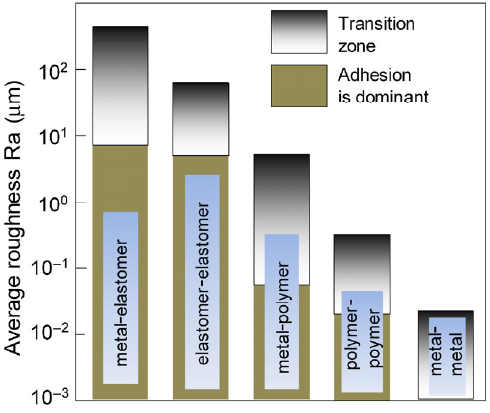
Fig. 5 Influence of adhesion interaction within contact of rough